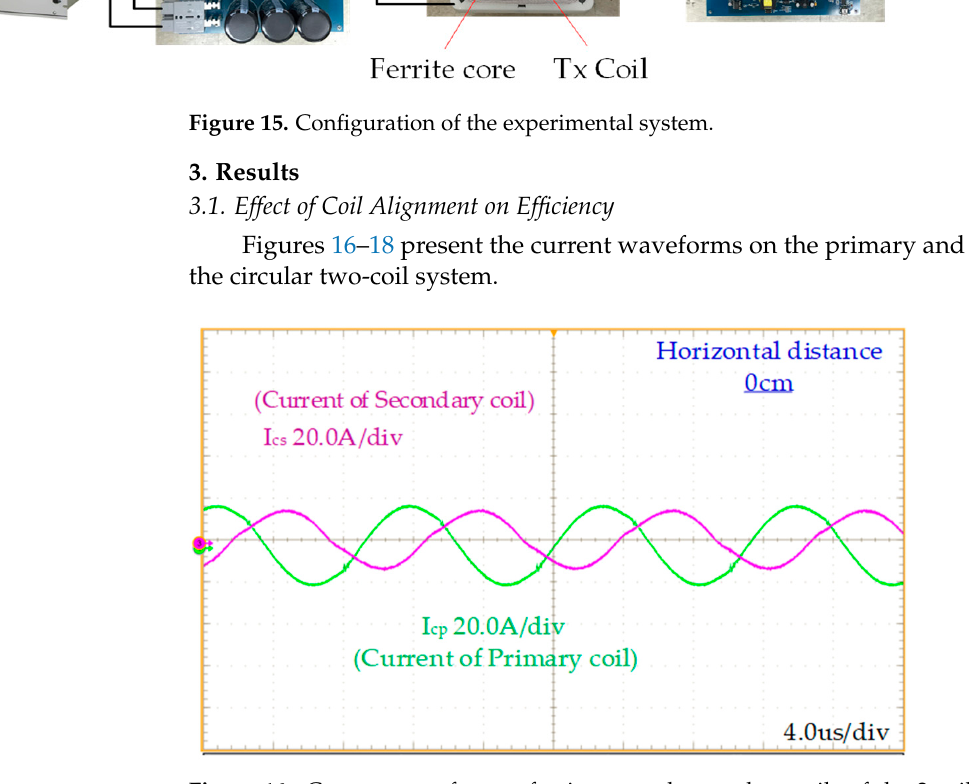
Figure 16. Current waveforms of primary and secondary coils of the 2-coil system (horizontal sepa- ration distance is 0 cm).